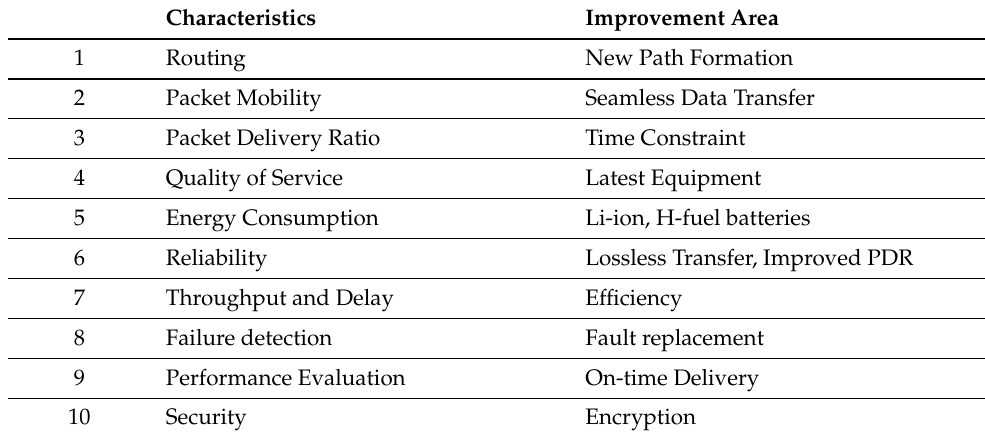
Table 2. Improvement areas for IoDs.